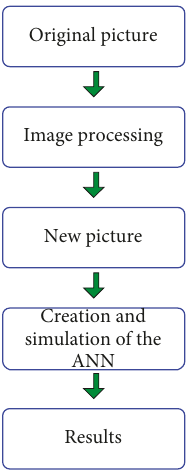
Figure 1: Cloud movement process with